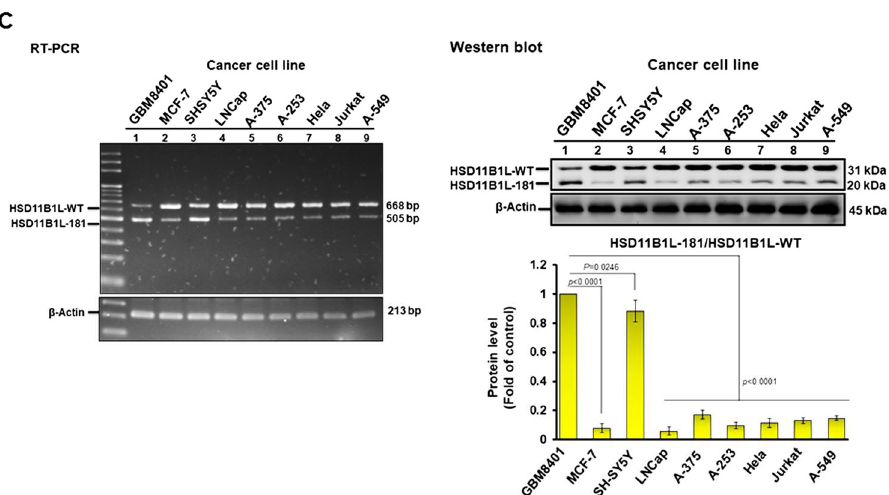
Figure 1. The splice variant HSD11B1L-181 of the HSD11B1L gene predominates in GBM. ( A ) Sim- plified transcript structure maps of HSD11B1L-WT and HSD11B1L-181. HSD11B1L-WT mature transcript consists of 8 exons. HSD11B1L-181 lacks exon 2 and exon 4, but adds to exon 2.1, causing the reading frame to shift to the penultimate amino acid at the end of exon 5 (a total of 134 amino acids are deleted, black box). Moreover, the splicing site changes in exon 8 resulted in partial deletion of the nucleotide sequence and shift of the reading frame. Finally, the original 63 amino acid sequence (blue box) was replaced with a different 92 amino acid sequence (red box). ( B ) Expression of HSD11B1L-181 is low in healthy human cells in brain but high in GBM cell lines. RT-PCR using designed primers on exon 6 and exon 8 to obtain HSD11B1L-WT and HSD11B1L-181 mature transcript fragments (top left). Representative results of agarose gel electrophoresis showing mature transcripts of HSD11B1L (668 bp) and HSD11B1L-181 (505 bp) (top right). Western blot showing bands for HSD11B1L-WT at 31 kDa and HSD11B1L-181 at 20 kDa (bottom left). β-actin is an internal loading control. Results were quantified using ImageJ (bottom right). ( C ) RT-PCR (top left) and Western blotting analysis (top right) showed that HSD11B1L-181 is less expressed in other cancer cell lines. The internal control is β-actin. Results were quantified using ImageJ (bottom right).